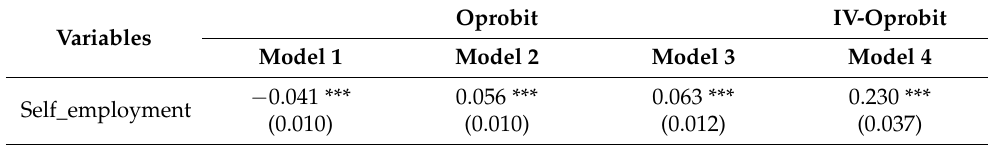
Table 3. Effect of self-employment on